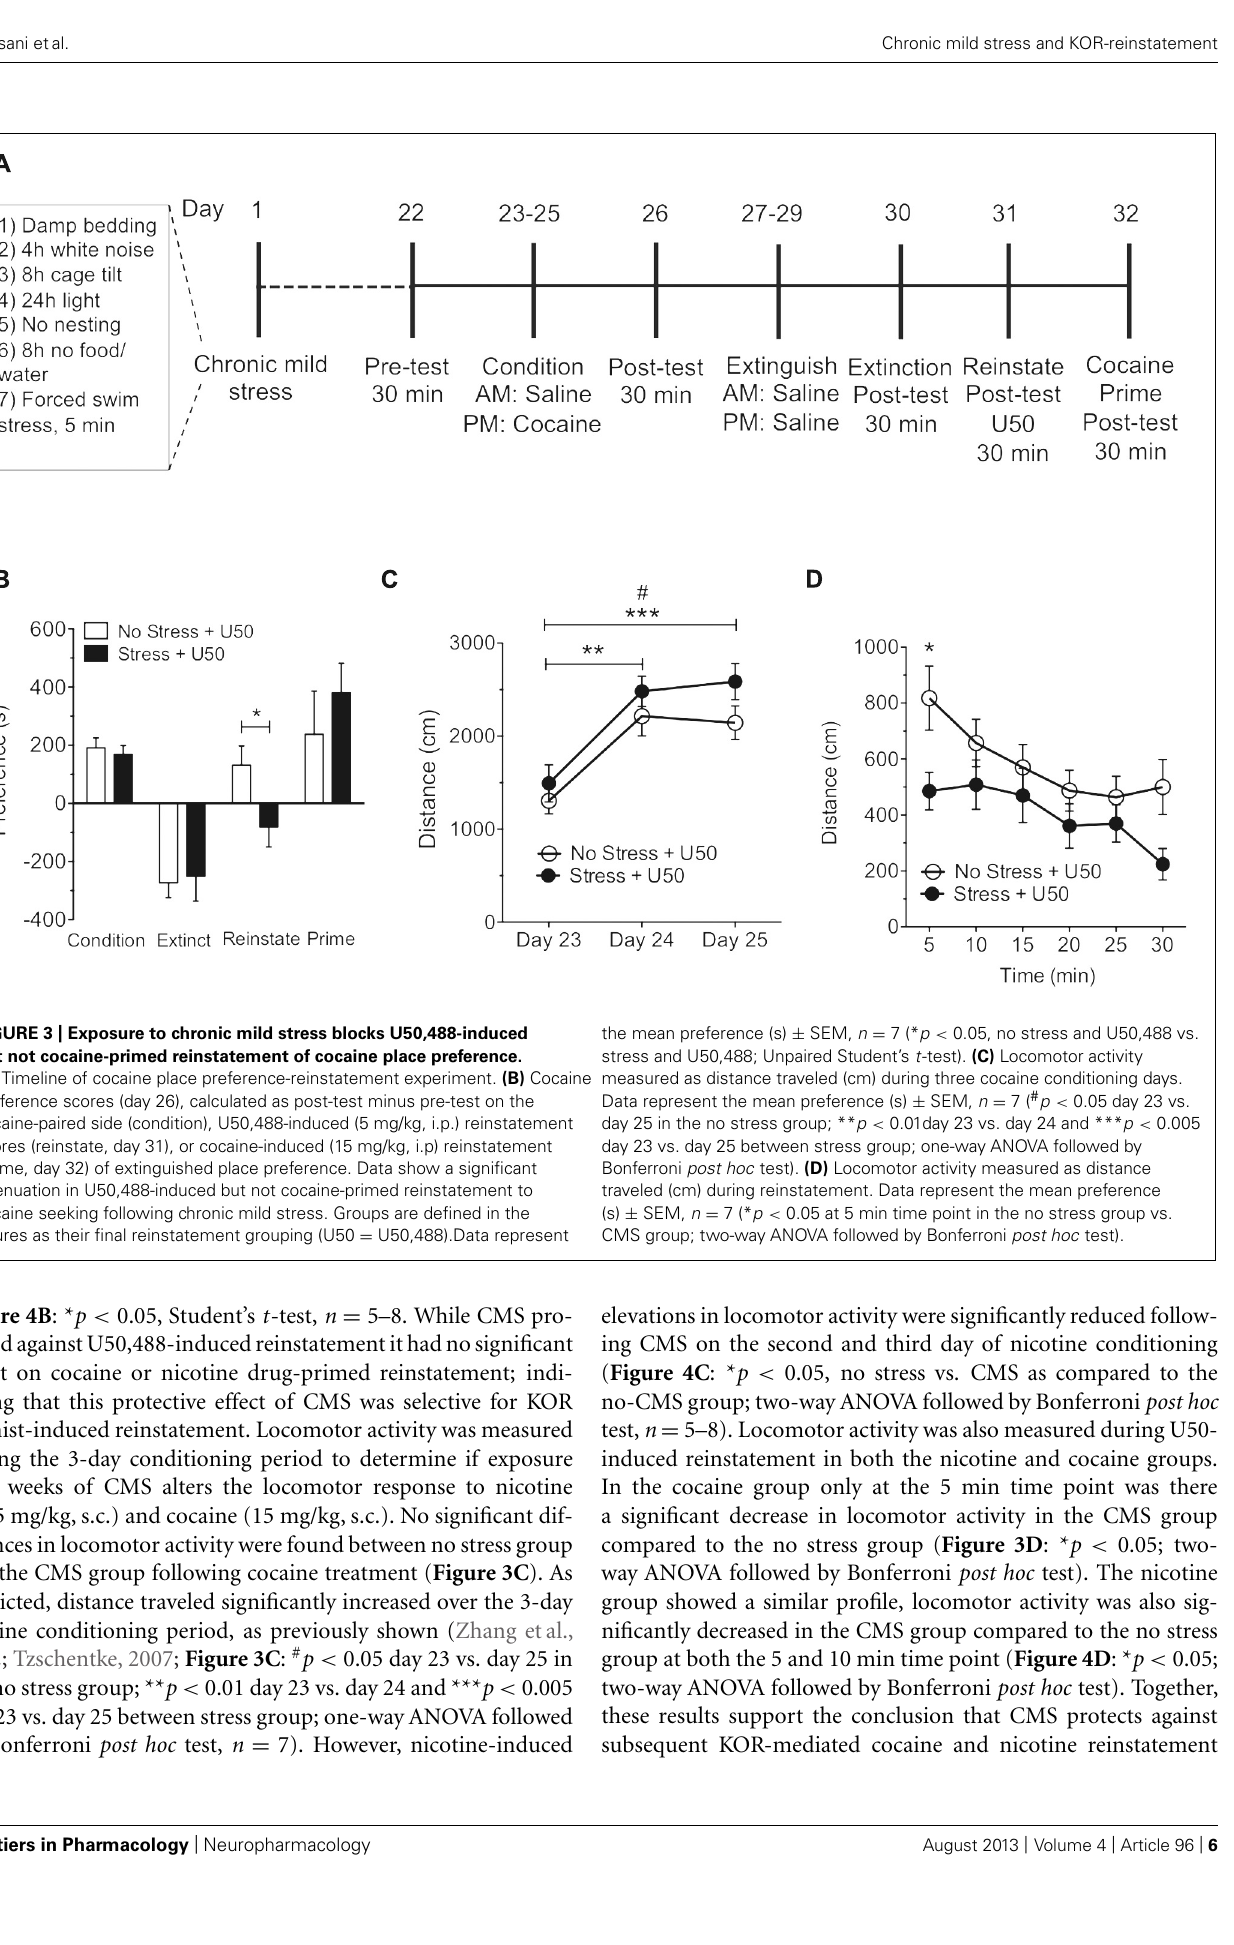
compared to the no stress group ( Figure 3D : * p < 0.05; two- way ANOVA followed by Bonferroni post hoc test). The nicotine group showed a similar profile, locomotor activity was also sig- group at both the 5 and 10 min time point ( Figure 4D : * p <